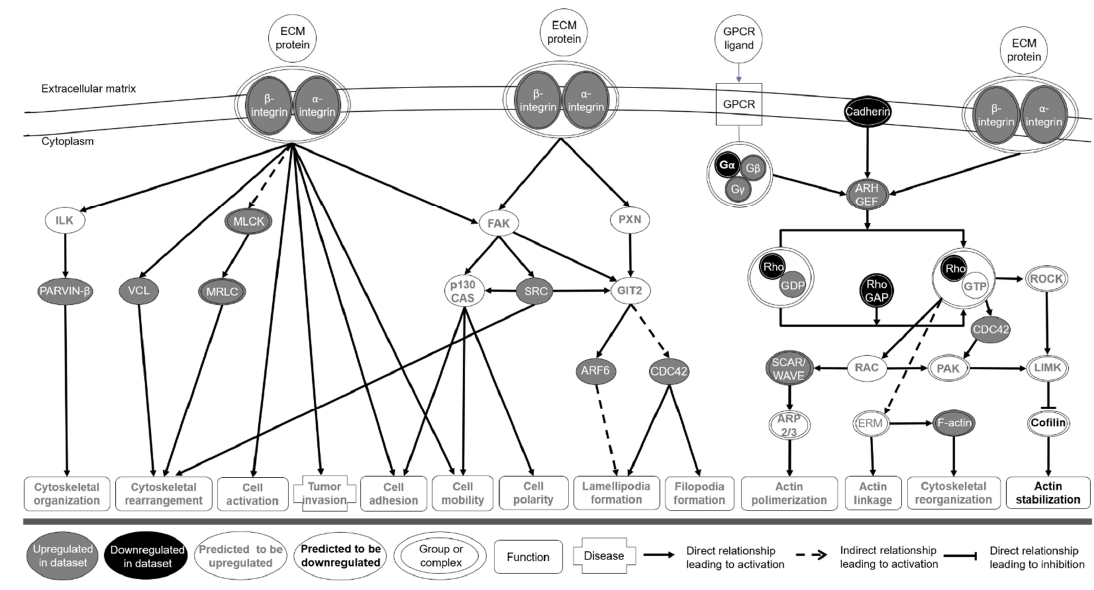
Figure 5. Predicted relationship between expressed and regulated genes within integrin, paxillin, and RhoGDI signaling pathways, and the consequent activation of diseases and biological functions in elderly individuals with T2D. The figure was adapted from the corresponding individual canonical signaling pathways generated by the Ingenuity Pathway Analysis system. ARF6, ADP-ribosylation factor 6; ARH, low density lipoprotein receptor adaptor protein 1; CDC42, Cell division control protein 42 homolog; ECM, extracellular matrix; ERM, ezrin/radixin/moesin; FAK, focal adhesion kinase; GEF, guanine nucleotide exchange factor; GIT2, G protein-coupled receptor kinase-interactor 2 isoform 4; GPCR, G protein-coupled receptors; GTP, guanosine triphosphate; ILK, Integrin-linked protein kinase; LIMK, lim kinase; MLCK, Myosin light-chain kinase; MRLC, myosin regulatory light chain; PAK; P21 activated kinase; PXN, paxillin; Rho GAP, Rho GTPase-activating proteins; VCL, vinculin.4.